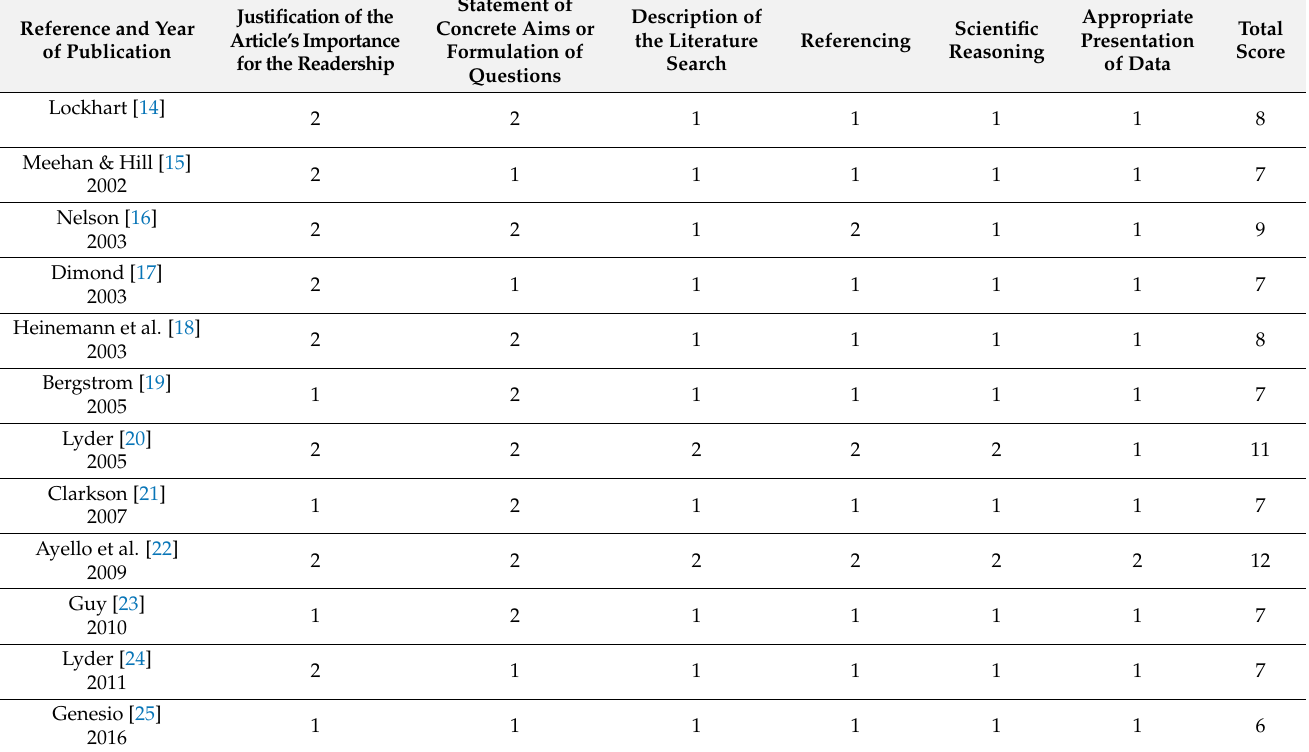
Table 1. SANRA Score for quality assessment of selected studies for the review.